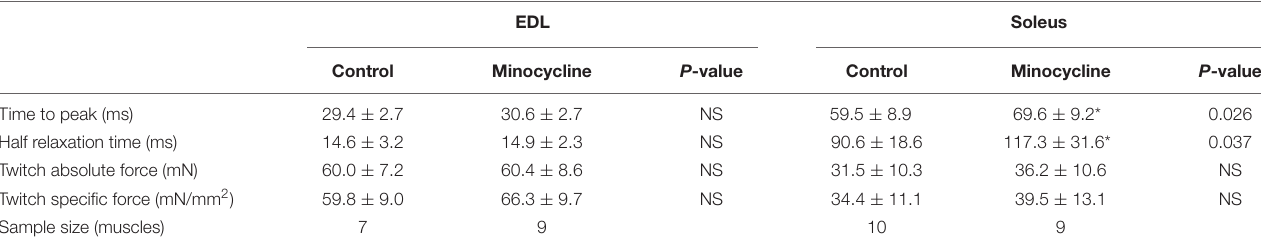
TABLE 2 | Statistical analyses and sample size of single twitch kinetics for fast-twitch EDL and slow-twitch soleus muscles for control and minocycline treated